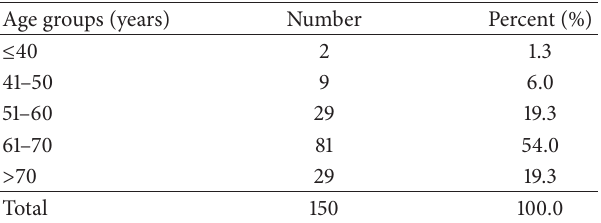
Table 2: Distribution of patients with anaplastic thyroid cancer according to age.